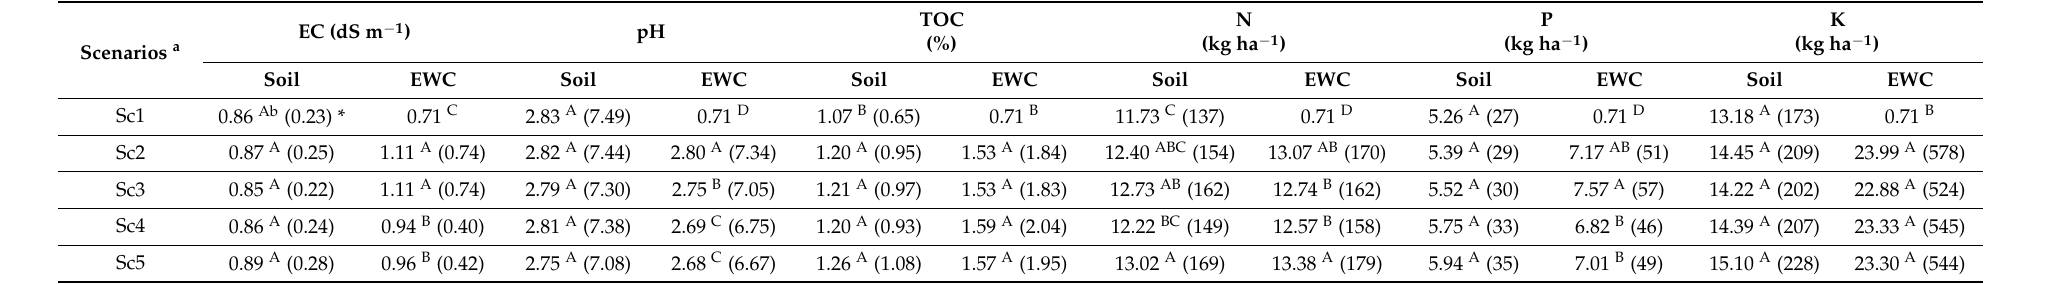
Table 3. Chemical properties of soil and earthworms cast (EWC) as influenced by mid-term CSA based management practices (data transformed through square-root